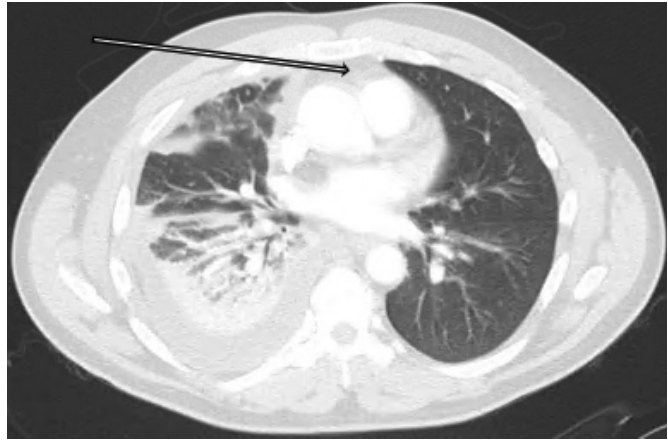
Image 3. Computed tomography angiogram of the chest. Arrow pointing at an encapsulated mediastinal fatty lesion with soft tissue stranding. Other notable findings include sympathetic right pleural effusion with right lung